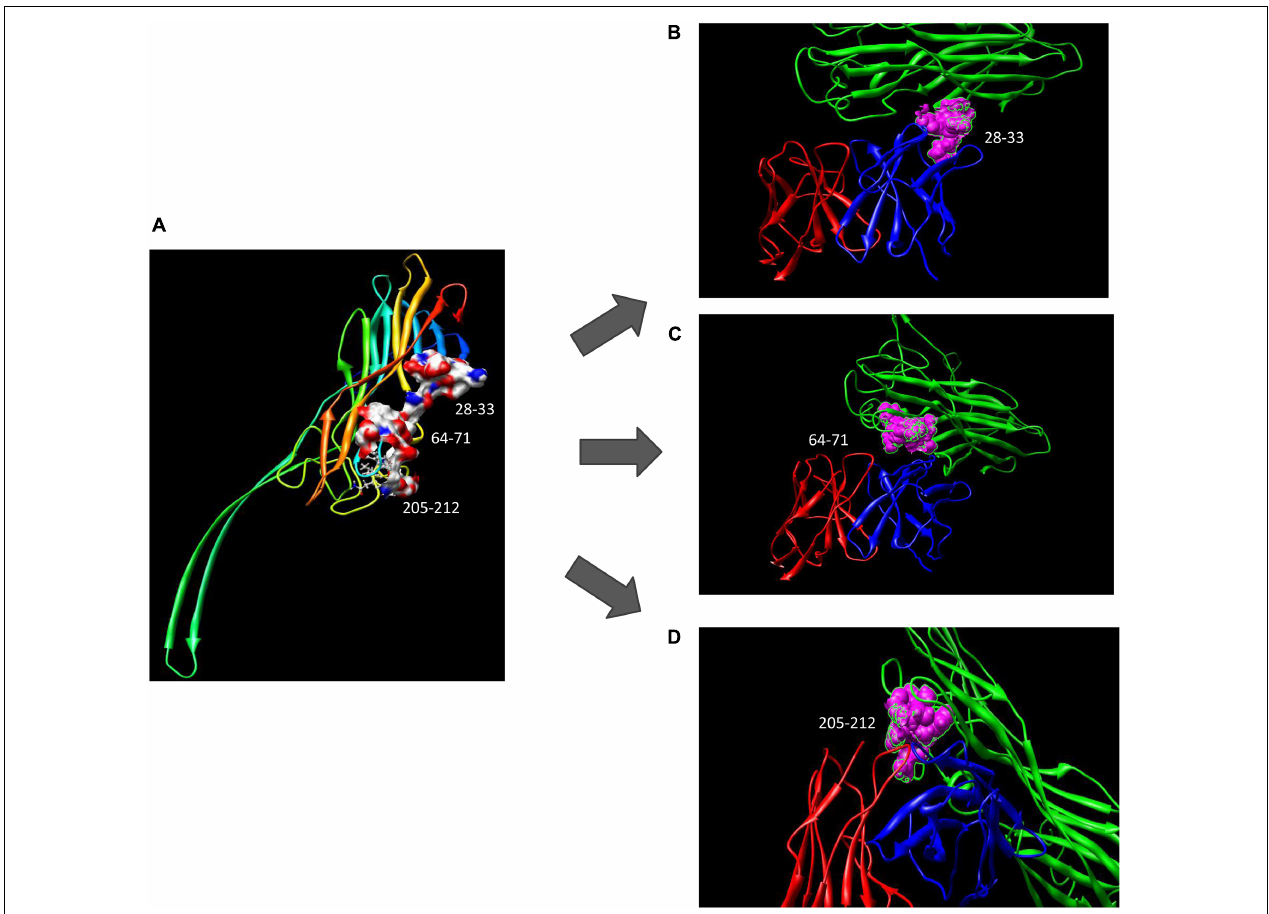
FIGURE 5 | The potential epitope distribution in Hla and the theoretical interaction mode between Hla and YG1. (A) The potential epitope distribution in Hla, i.e., the hydrophobic and hydrophilic map of the epitopes (including 28–33, 64–71, and 205–212). (B) The interaction mode between the epitope at positions 28–31 and YG 1. Green denotes Hla, red denotes VL, and blue denotes VH. (C) The interaction mode between the epitope at 64–71 and YG1. Green denotes Ma, red denotes VL, and blue denotes VH. (D) The interaction mode between the epitope at 205–212 and YG1. Green denotes Hla, red denotes VL, and blue denotes